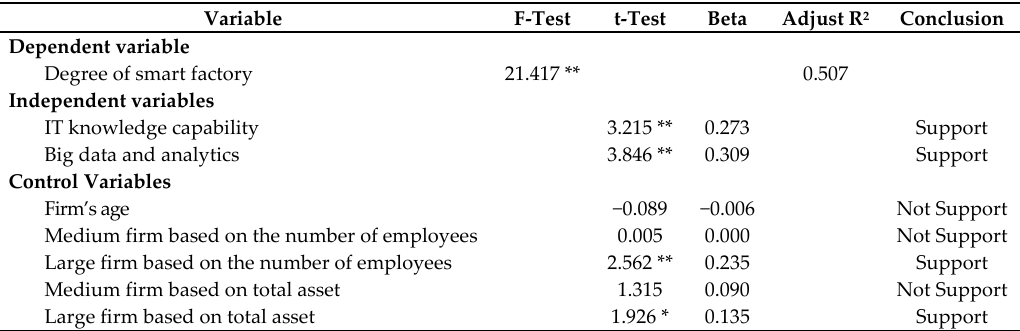
Table 2. Result of multiple regression analysis on